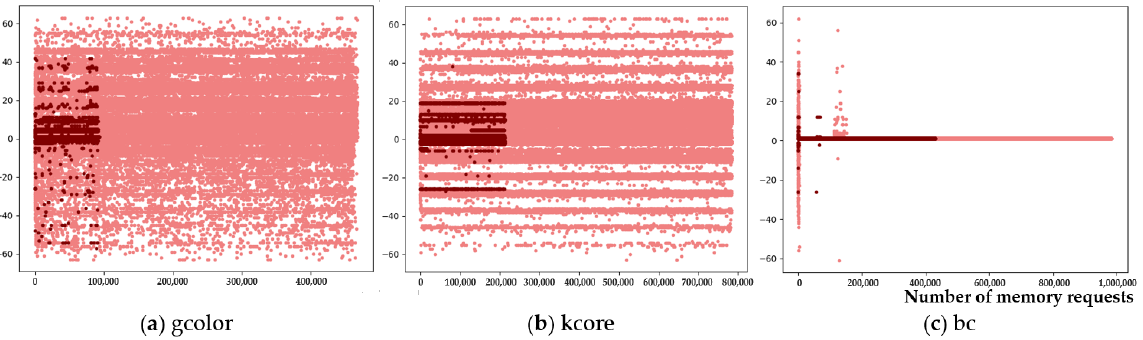
Figure 11. Coverage of module-S.